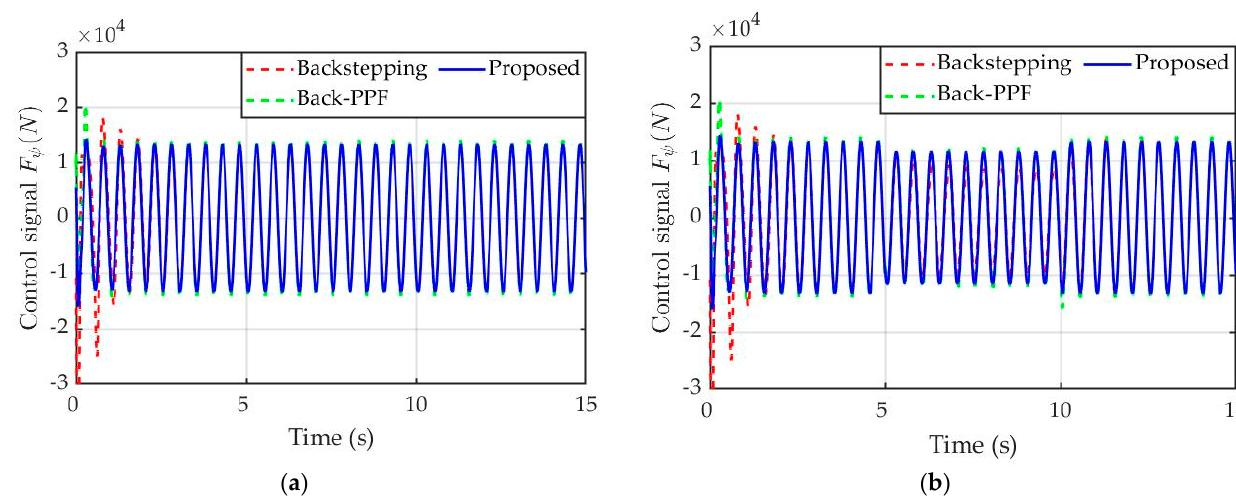
Figure 10. Control signals ψ F (N): ( a ) Non-fault; ( b ) Actuator-fault.